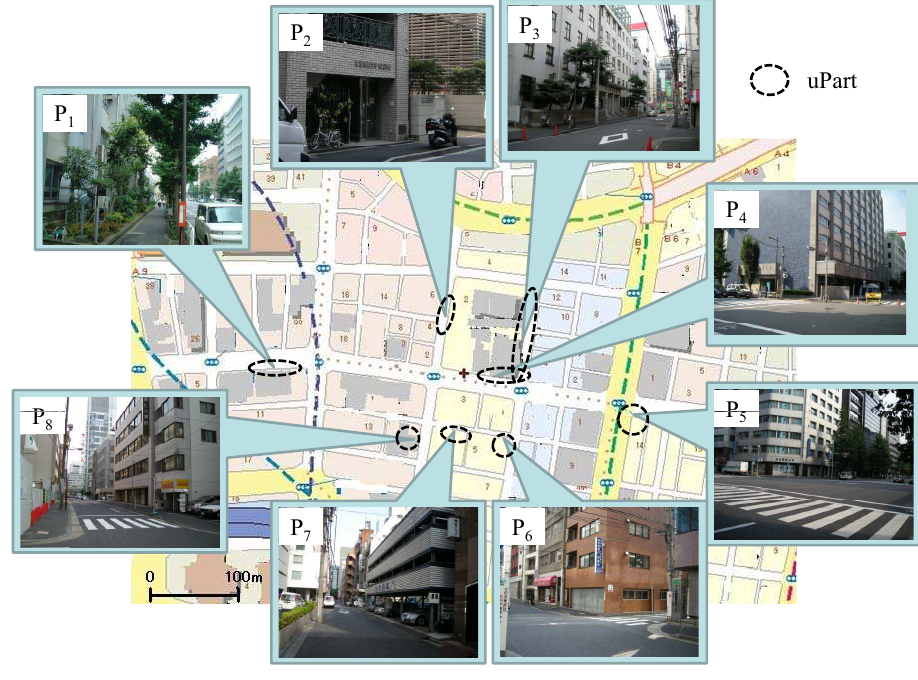
Figure 3. An example of sensor deployment at observation point 𝑃